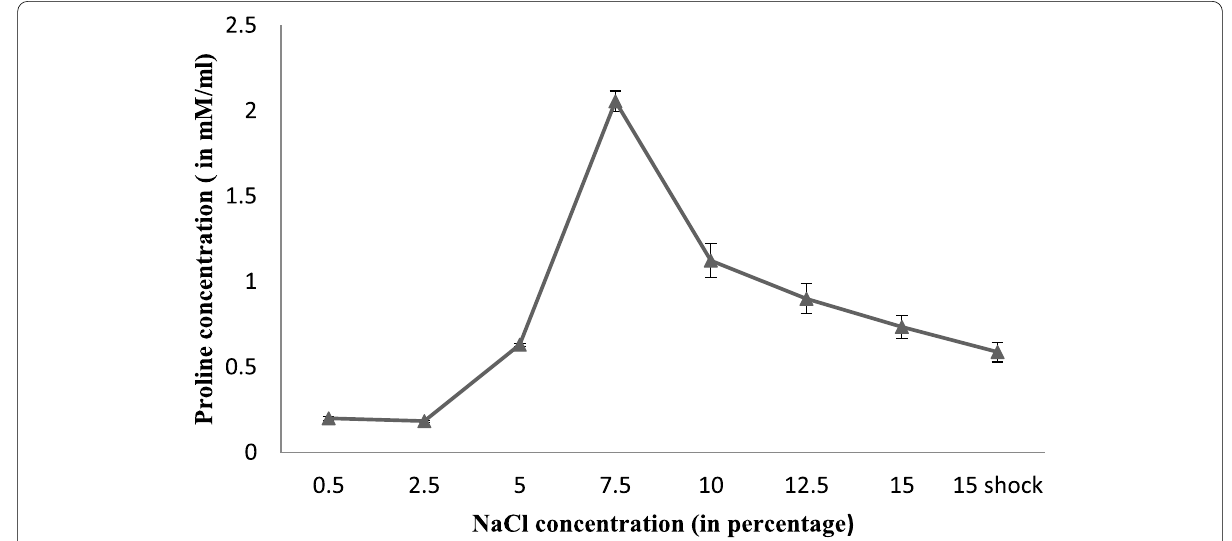
Fig. 4 Estimation of total proline accumulation (mM/ml) at varying NaCl concentrations